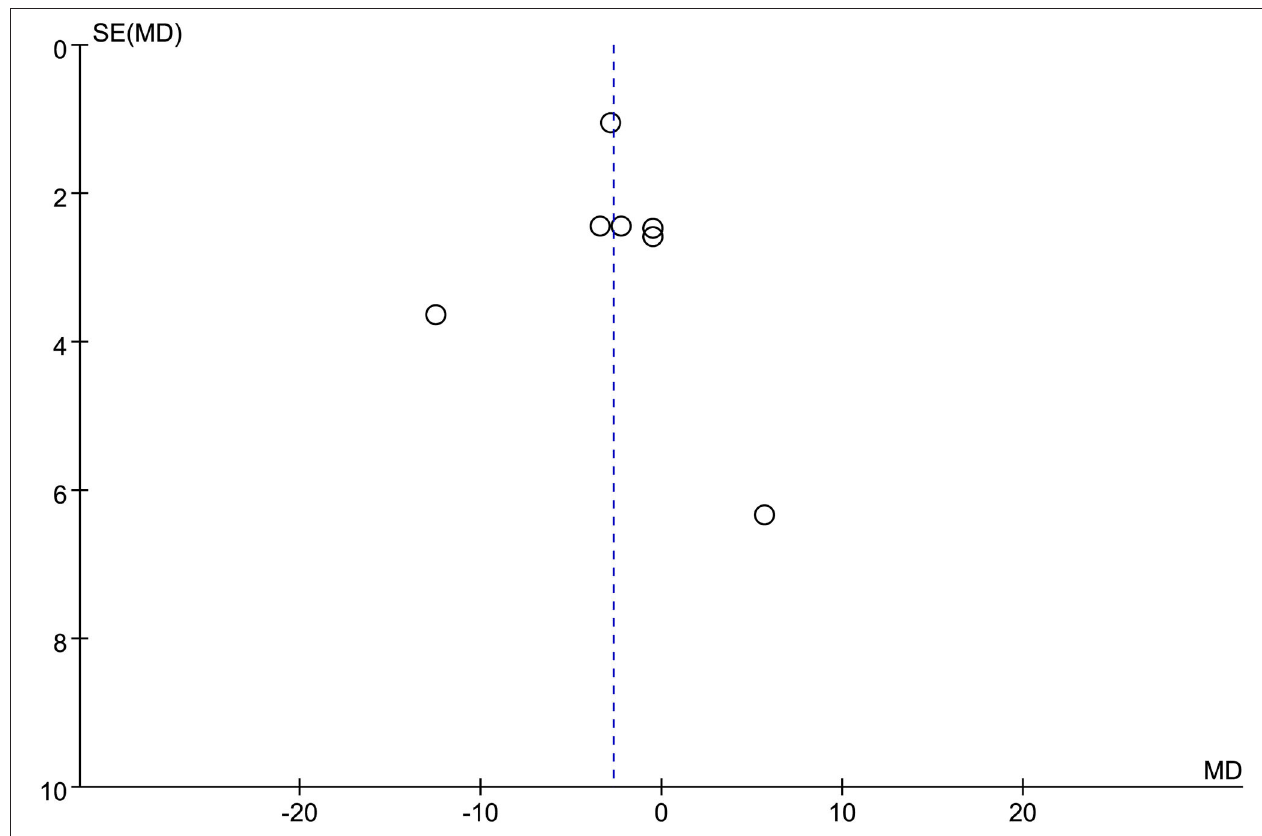
FIGURE 7 | Funnel plot of procedure time between EUS-CDS and EUS-HGS.